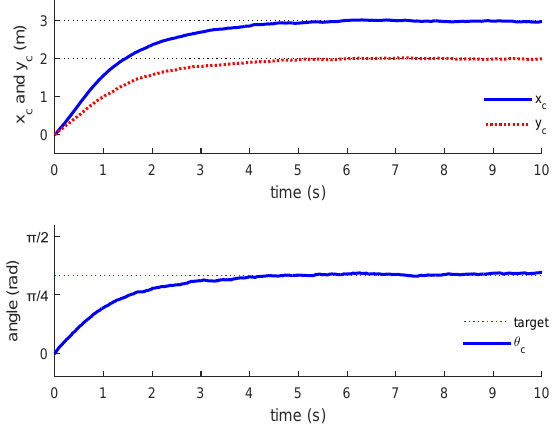
Figure 8. The state trajectories of the OMR in Cartesian